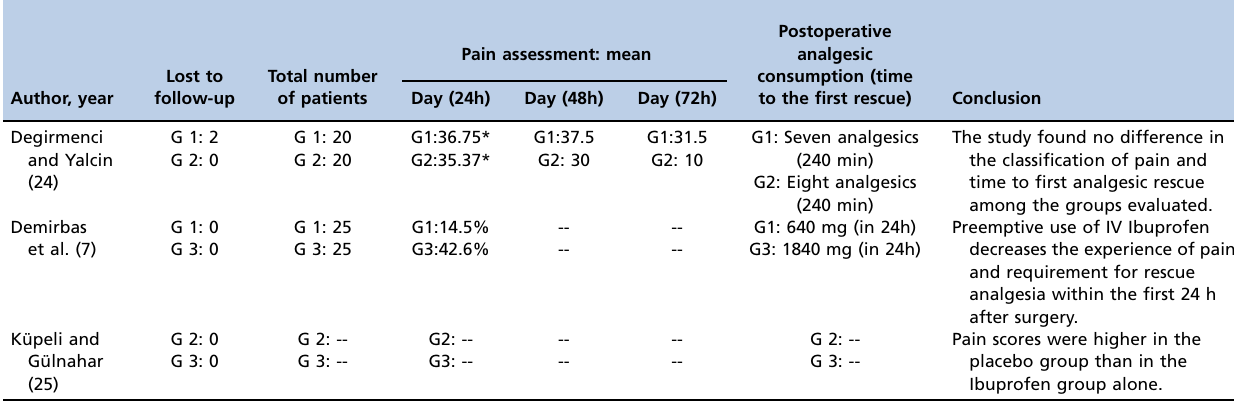
Table 4 - Summary of the main qualitative/quantitative characteristics of the eligible